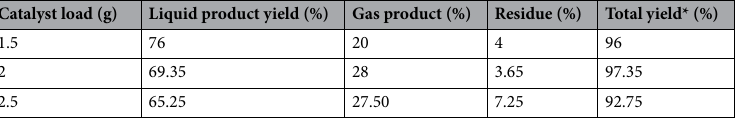
Table 6. Results of catalyst amount effect on thermo catalytic cracking process*. *Sum of liquid product & gas product only. WCO Feed = 100 g, T = 450 °C, Time = 15 min., Initial Pressure of Nitrogen = 5 bar.